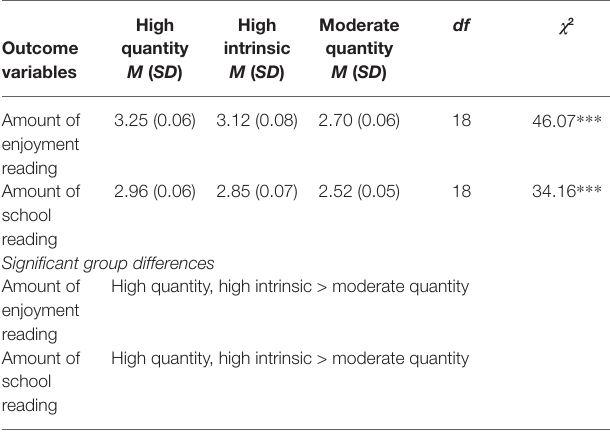
Moderate quantity